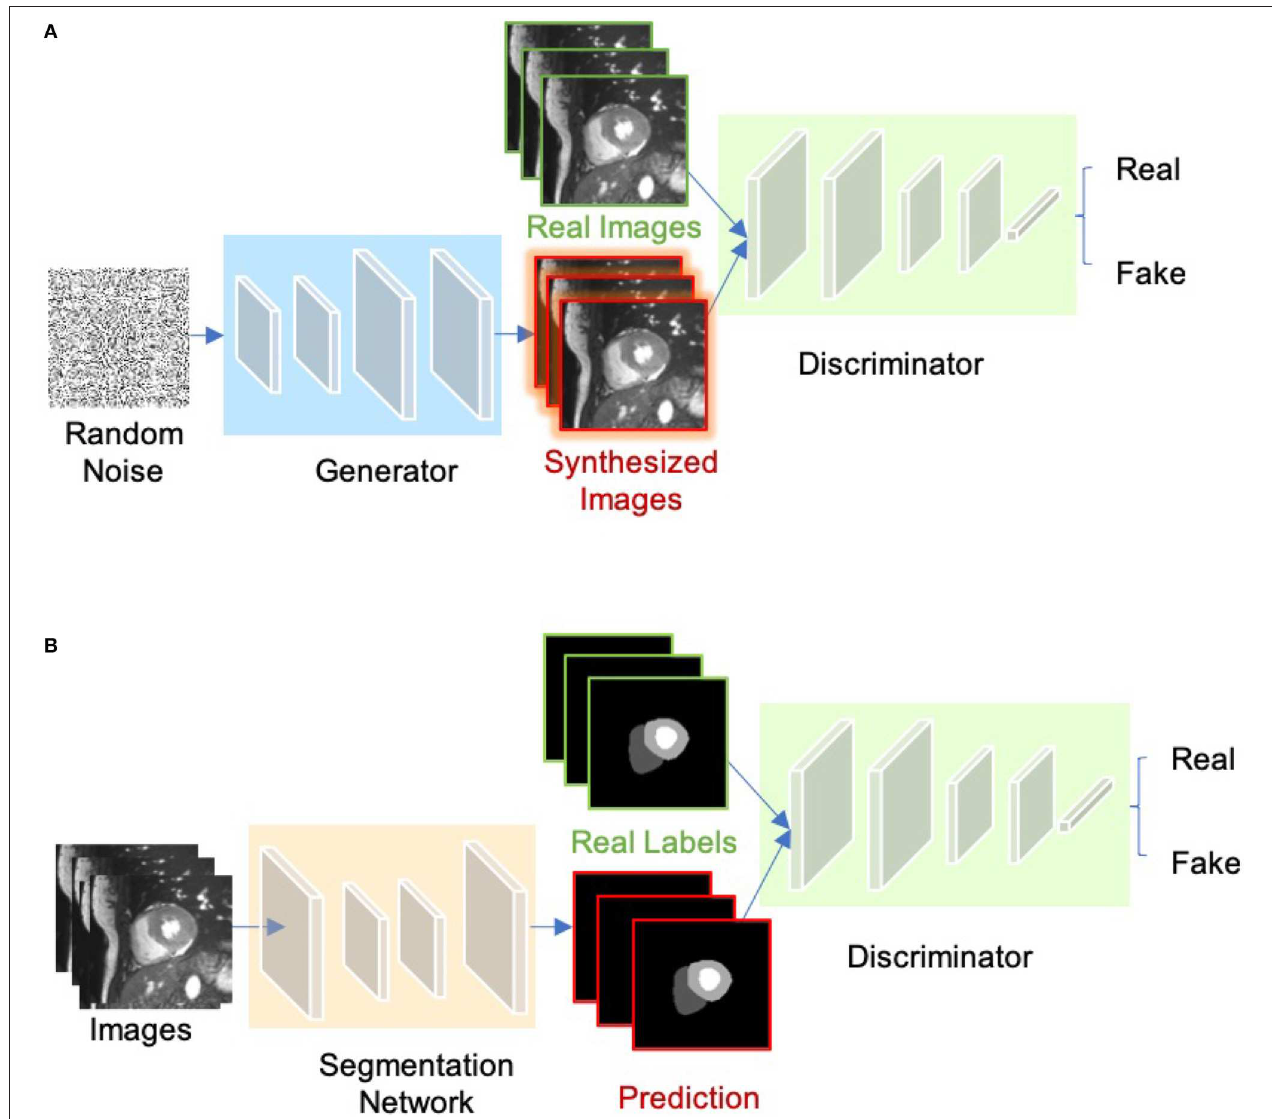
FIGURE 7 | (A) Overview of GAN for image synthesis. (B) Overview of adversarial training for image